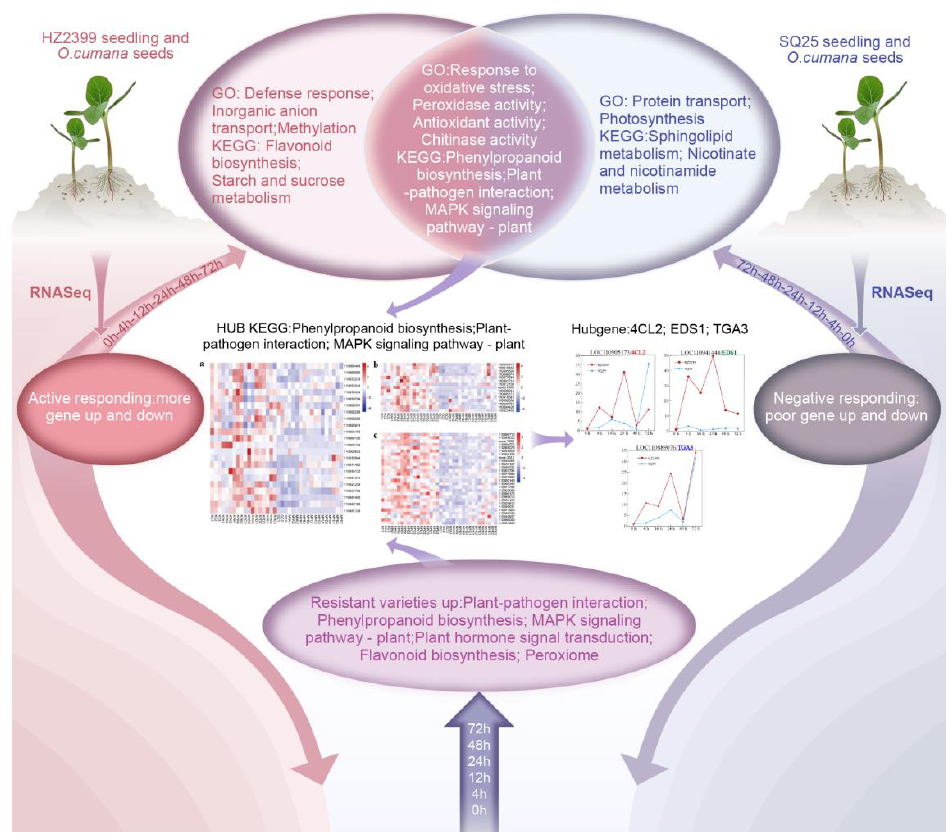
Figure 11. Overview figure of the results in the present study.